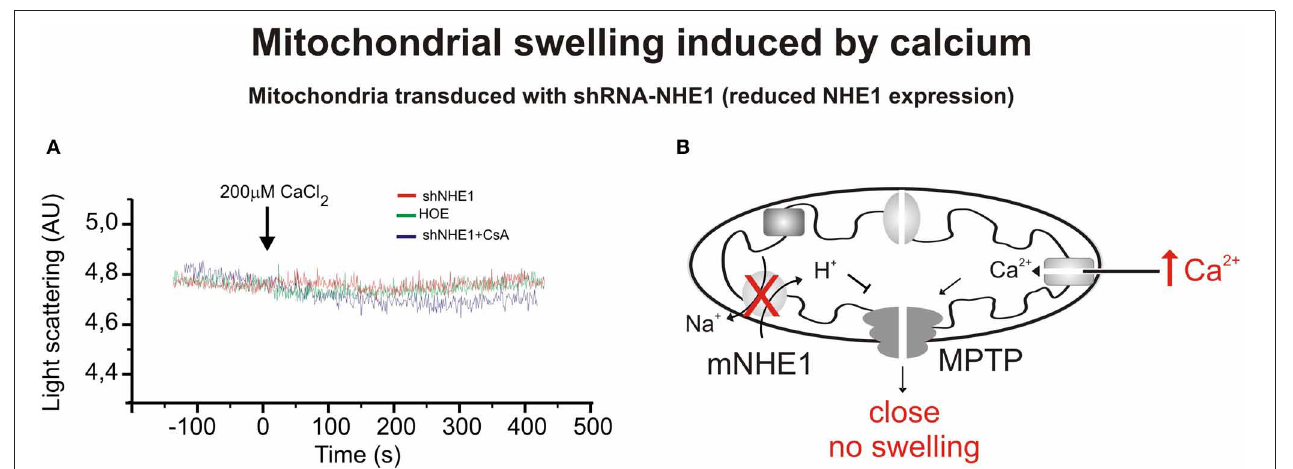
FIGURE 2 | Mitochondrial swelling induced by CaCl 2 . (A) Typical experiment showing the scattered light absorbance traces of Ca 2 + -induced swelling in response to addition of CaCl 2 for heart mitochondria isolated from rats transduced with shRNA-NHE1 in the presence and absence of cariporide. The shRNA-NHE1 transduction significantly inhibited Ca 2 + -induced mitochondrial swelling compared with SCR-transduced animals, (as previously shown in Figure 1 ). Cariporide